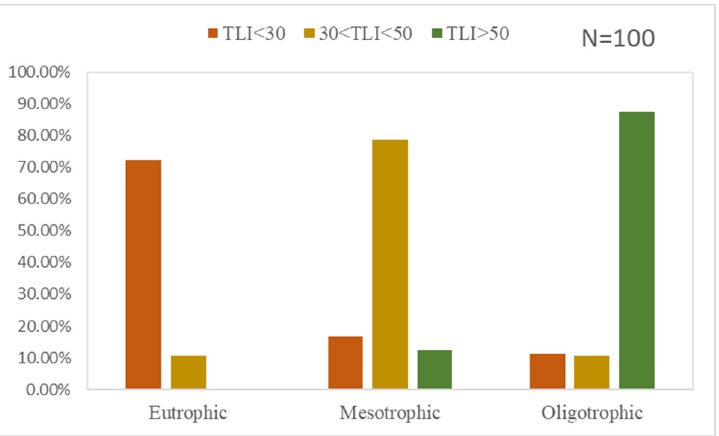
Figure 10. In situ TLI in each FUI-based trophic state waters.